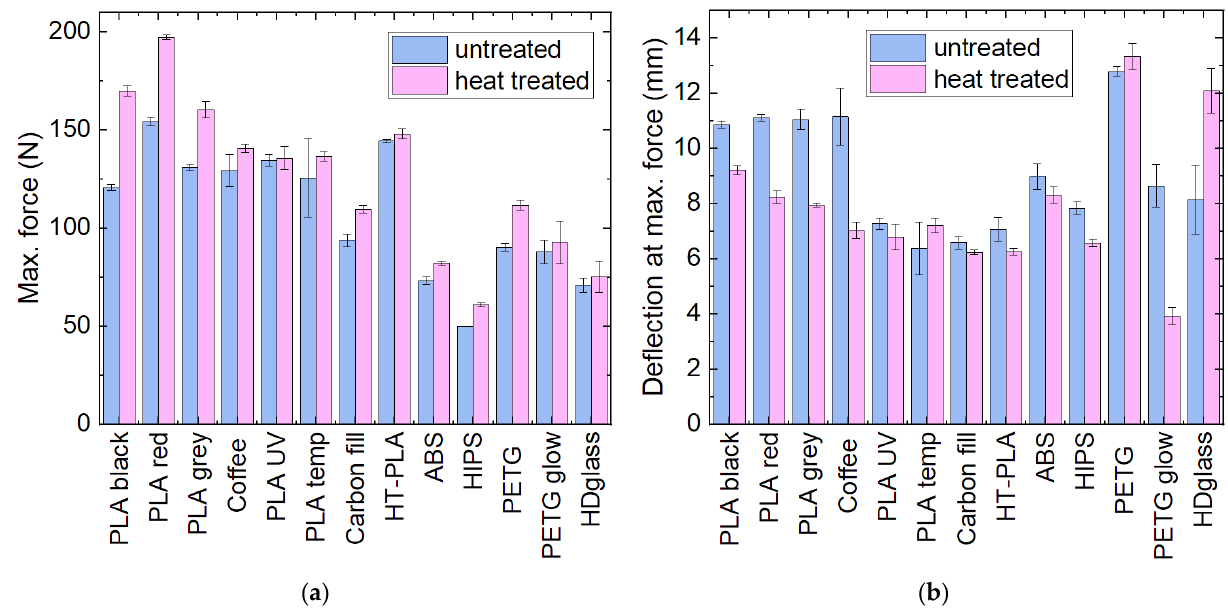
Figure 2. Mechanical properties of the samples as printed and after heat treatment: ( a ) maximum force; ( b ) deflection at maximum force in 3-point bending tests.